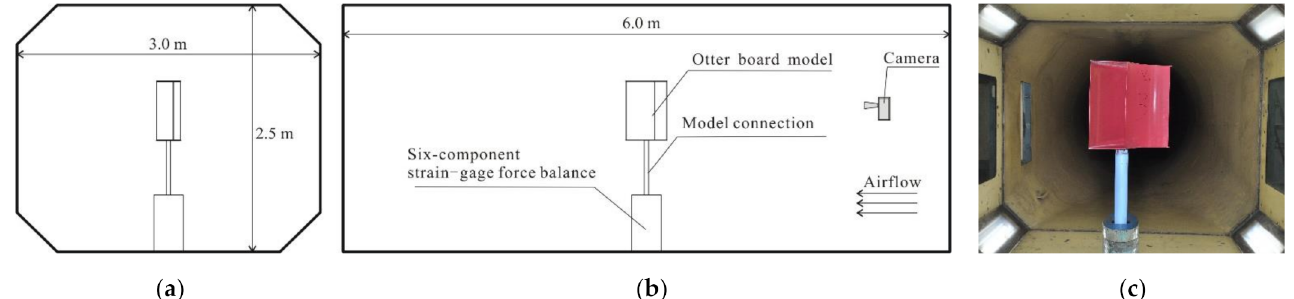
Figure 3. Otter board model in the wind tunnel: ( a ) Left side view; ( b ) Front view; ( c ) Photograph taken on the right in the wind tunnel before testing; there was no camera when